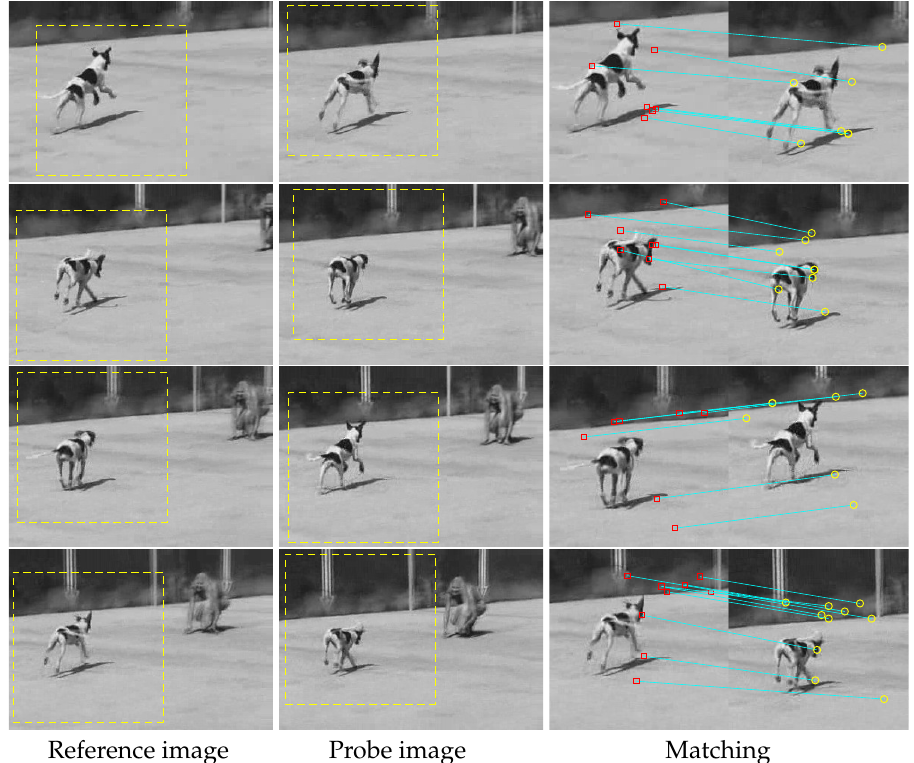
Figure 5. First feature matching test. In the first two columns, moving objects are marked, and, in the last column, there are marked key-points (as red squares and yellow circles for better visualization) with an indication of their position on two different frames with a blue